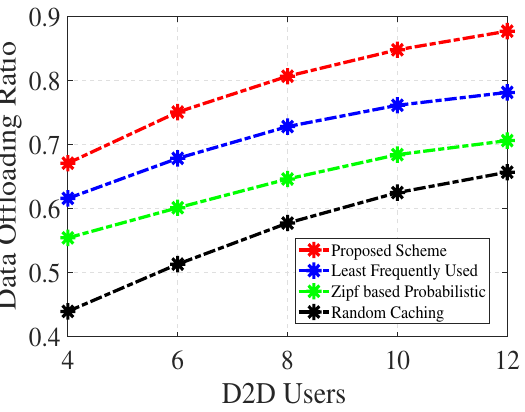
Figure 4. Data offloading ratio versus D2D users with F = 100, H = 50 MB, and Q = 0.4